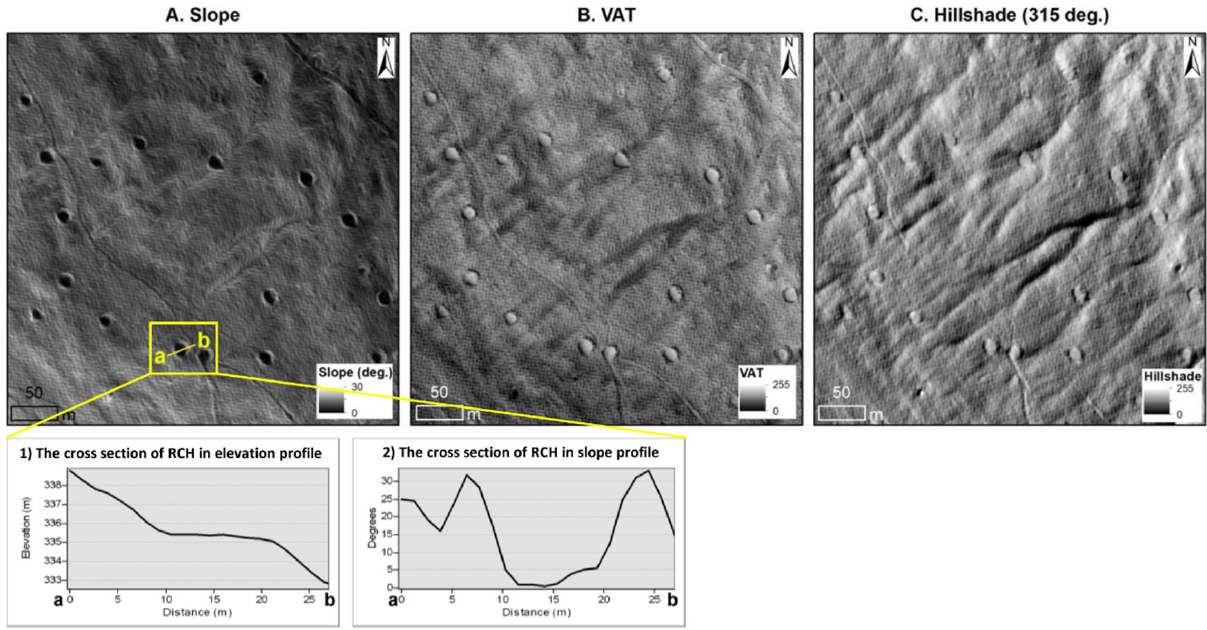
Figure 2. Visualization of RCHs in three different rasters derived from a LiDAR DEM. ( A ) slope, ( B ) VAT (Visualization for Archaeological Topography), ( C ) hillshade; Note that (1) and (2) indicates an example cross section (a,b) through a RCH showing the elevation and slope profiles, respectively.